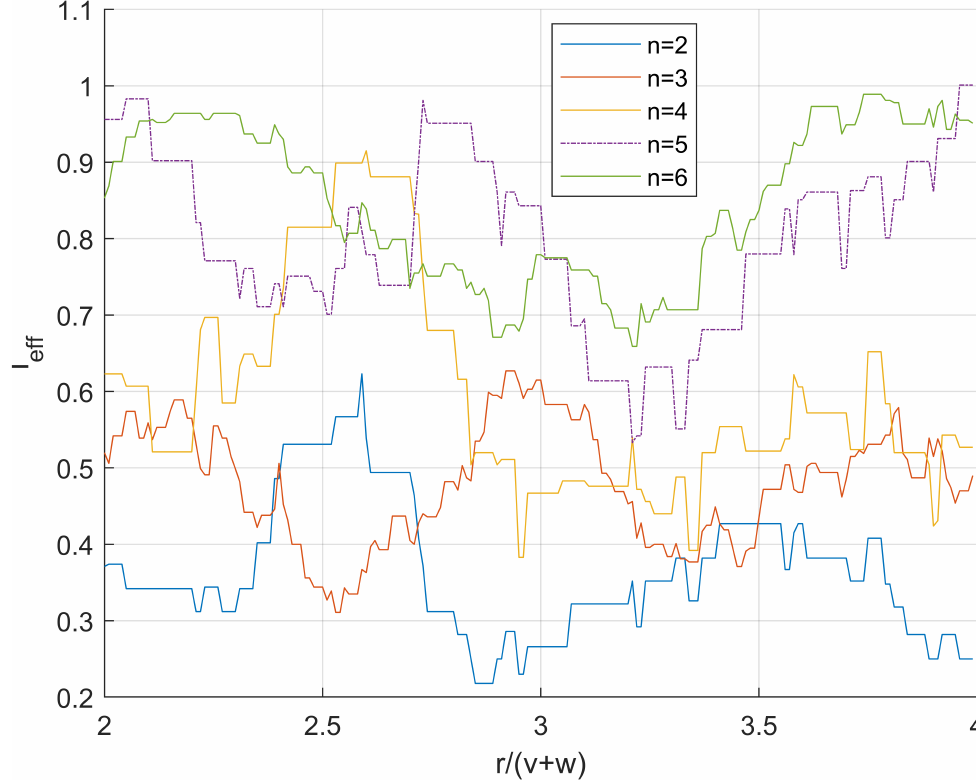
Figure 3. I eff vs. the relative radius r for different values of the number n of pins. v + w is the sum v + w of the widths of the conductive band and the insulator (the border of each square of the